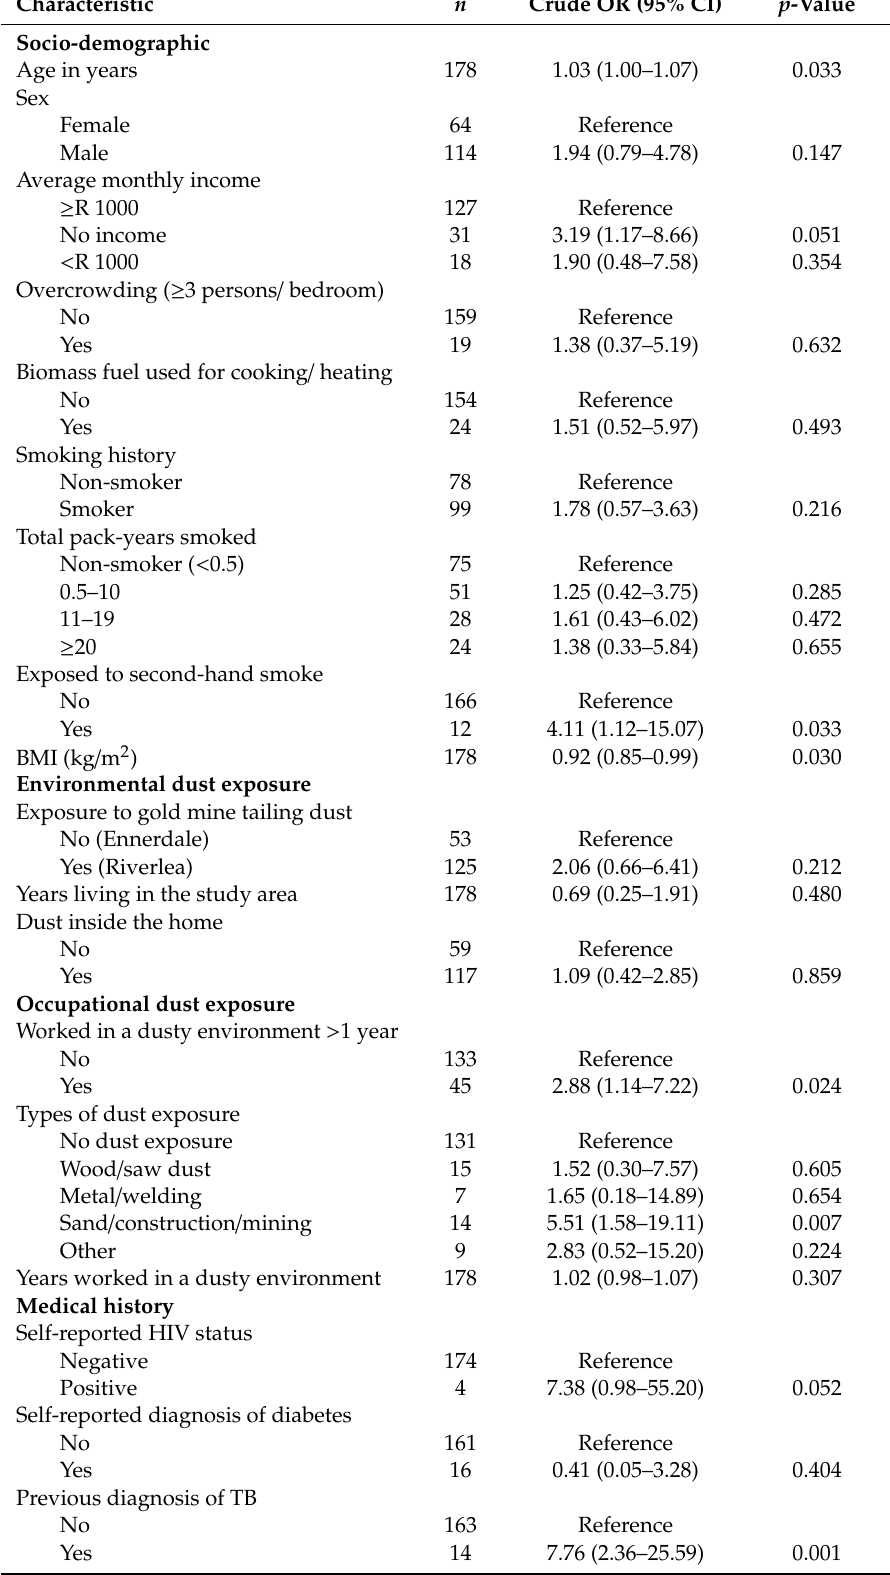
Table 2. Univariate analysis of socio-demographic, occupational and clinical factors associated with radiological pulmonary tuberculosis